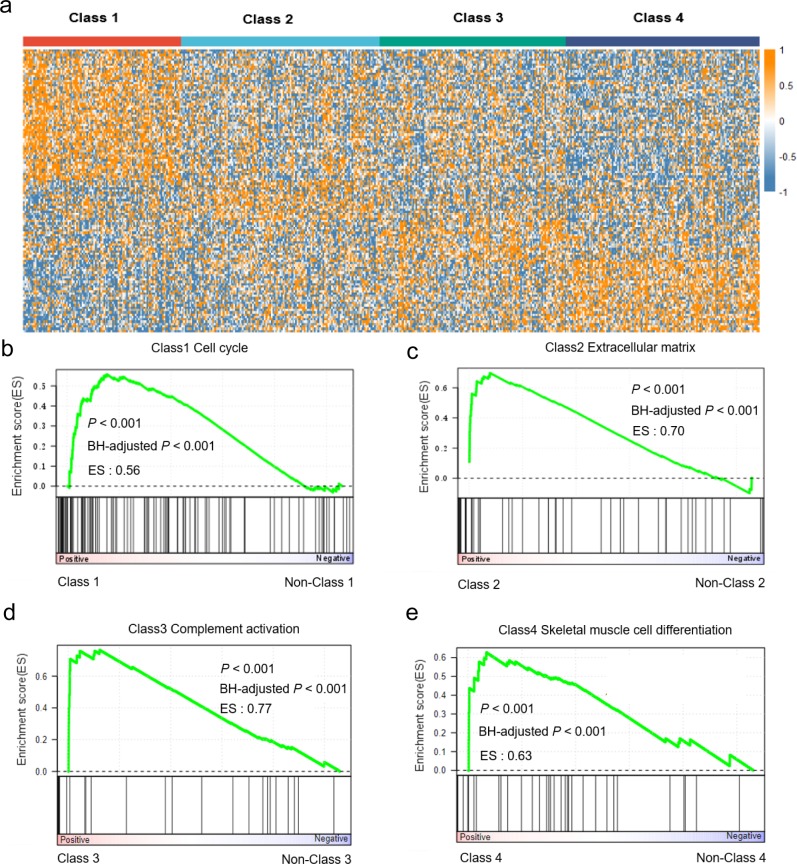
Differential gene expression and pathway analyses in ovarian cancer.(a) Heatmap illustrating signature genes that are differentially expressed between identified clusters. (b-e) GSEA plot illustrating a representative pathway dysregulated in each molecular subtype identified.